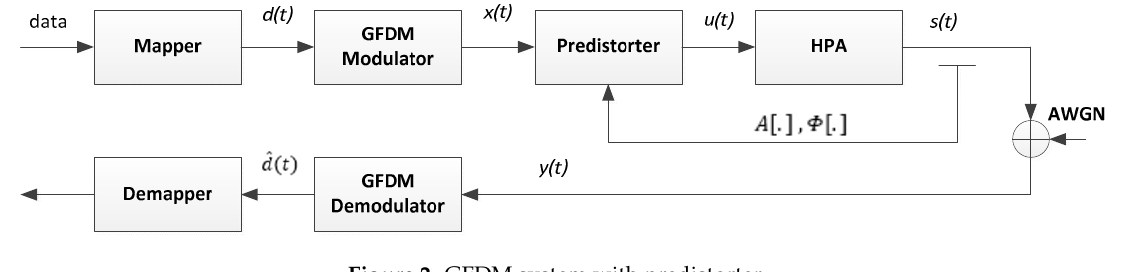
Figure 2. GFDM system with predistorter.